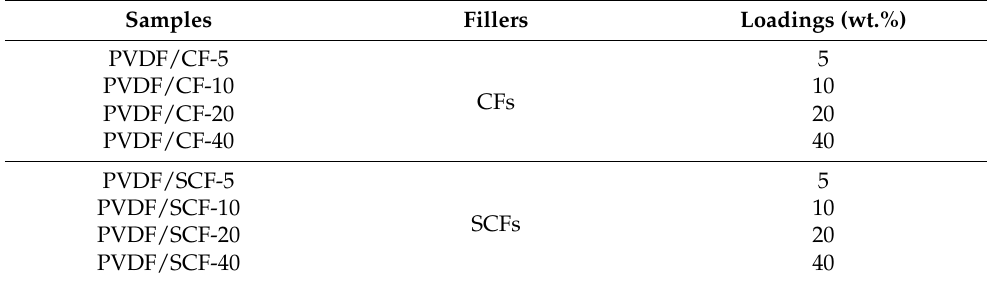
Table 1. Sample information of the prepared composites, in terms of filler loadings.